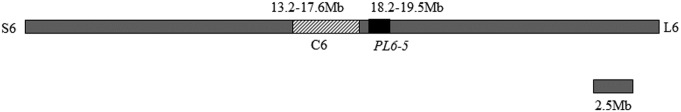
Map position of QTL PL6-5 in the pericentromeric region on chromosome 6.The abbreviations S6 and L6 denote the short arm and long arm region of chromosome 6 respectively. C6 indicates the centromere region from 13.2 Mb to 17.6 Mb. The physical position of QTL PL6-5 was mapped between 18.2 Mb and 19.5 Mb and this region is close to the centromere, separated by only 600 kb.